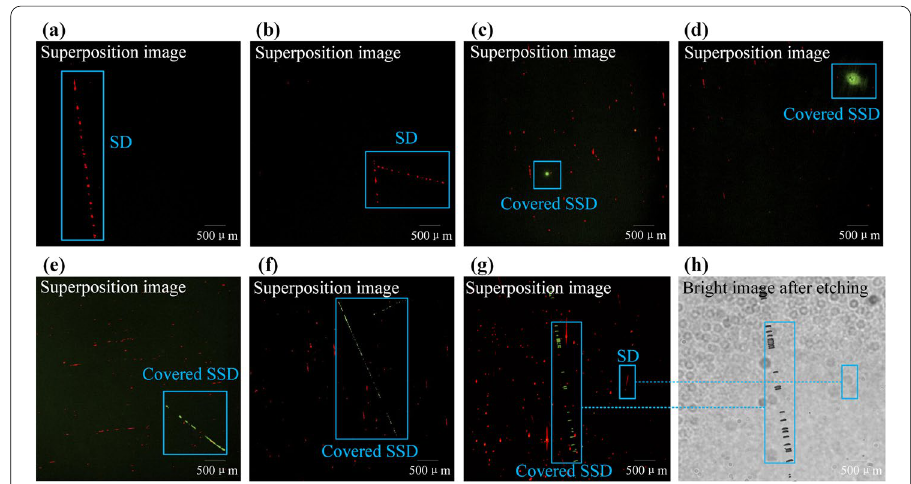
Fig. 3 Imaging results and etching verification of SDs and covered SSDs. a b Superposition images, there are SDs in the figures (surface scratches in red areas). c d e f Superposition images, there are covered SSDs in the figures (polishing points and scratches in green areas). g h Superposition image before etching and its bright image after etching, there is a SD (shallow surface scratch) which disappears after etching, and a covered SSD (polishing scratch) which is exposed after etching